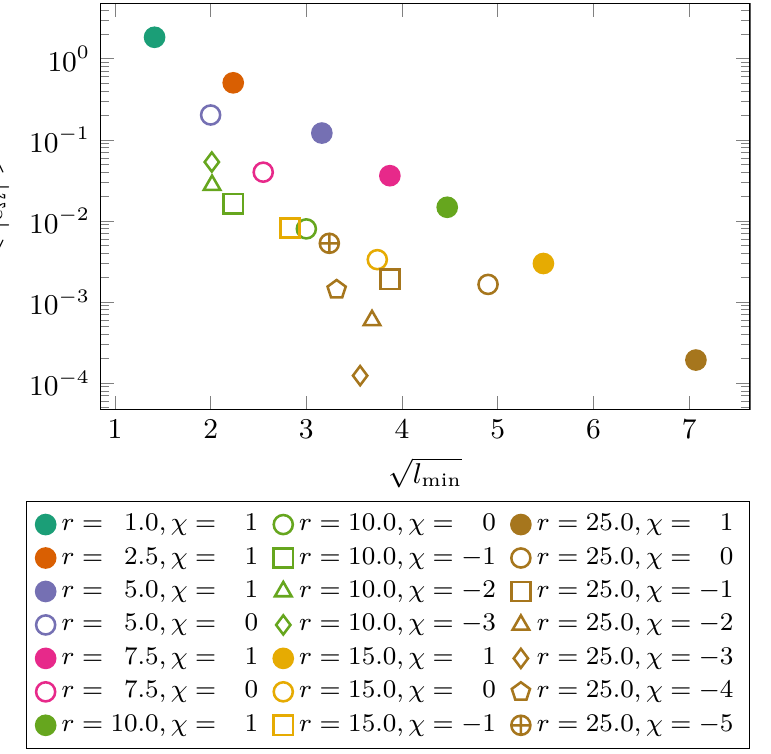
Figure 10. Average absolute relative error < | (cid:101) Ω | > as a function of the minimal characteristic length scale of the system, l min . In the case of a pore without rods, this distance is twice the radius. When rods are present within the pore this is the smallest distance between the pore wall and a rod or between two different